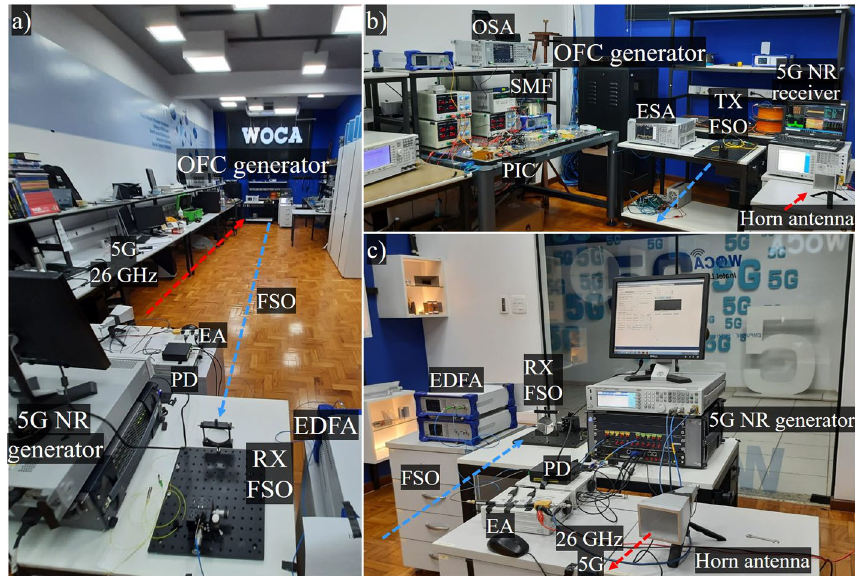
Figure 8. OFC-based 5G NR mm-waves system experimental setup photographs. ( a , c ) The back and front views, respectively, of the FSO reception, the PD followed by the electrical amplifiers chain, 5G NR generator